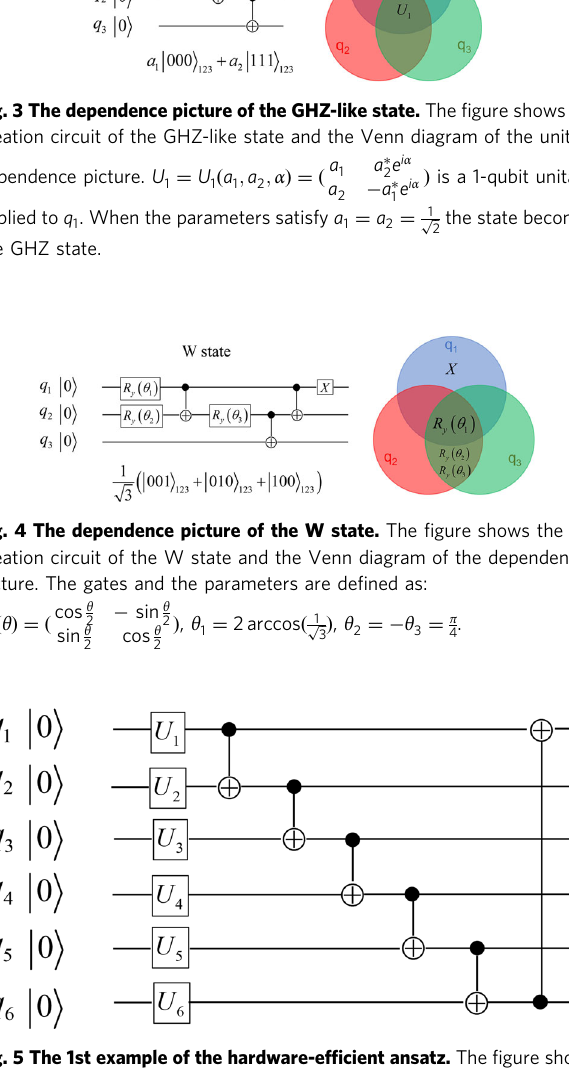
q q 1 through 6 ,